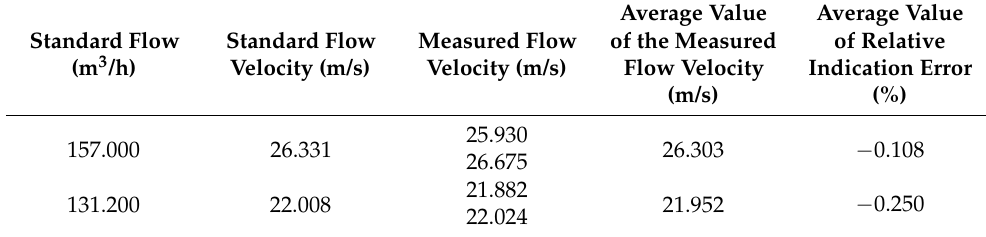
Table 7. Measurement results at high flow velocity.